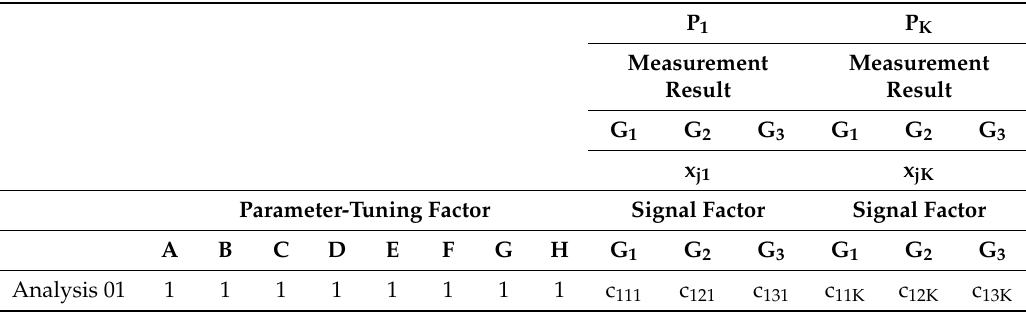
Table 1. Design of experiments (DOE) for multi-feature parameter tuning.